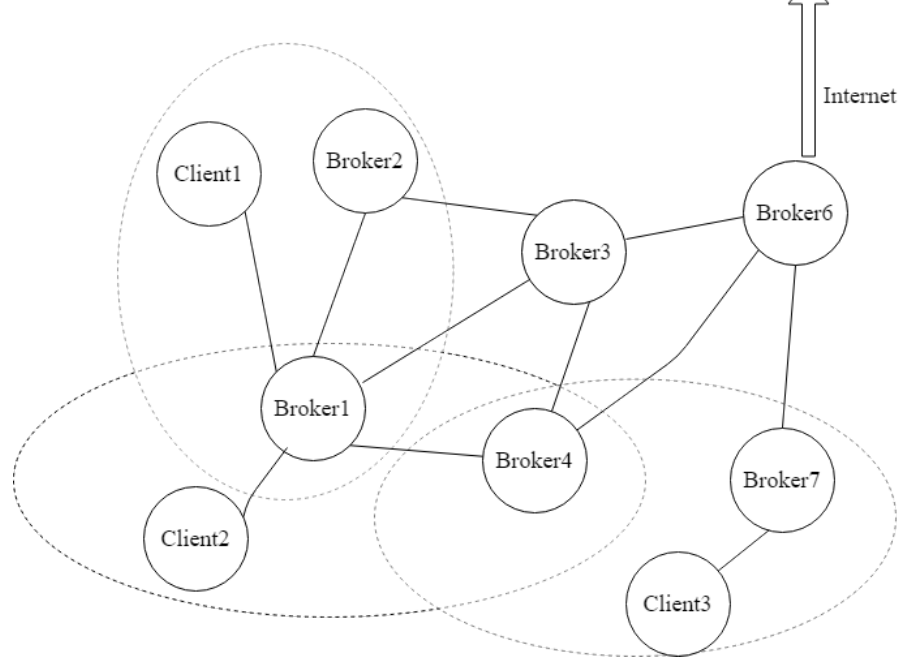
Figure 1. A simple example showing the relations among clients and